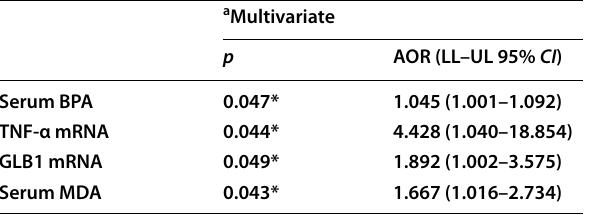
AOR adjusted odd’s ratio CI confidence interval, LL lower limit, UL upper limit a Adjusted with age (years) * Statistically significant at